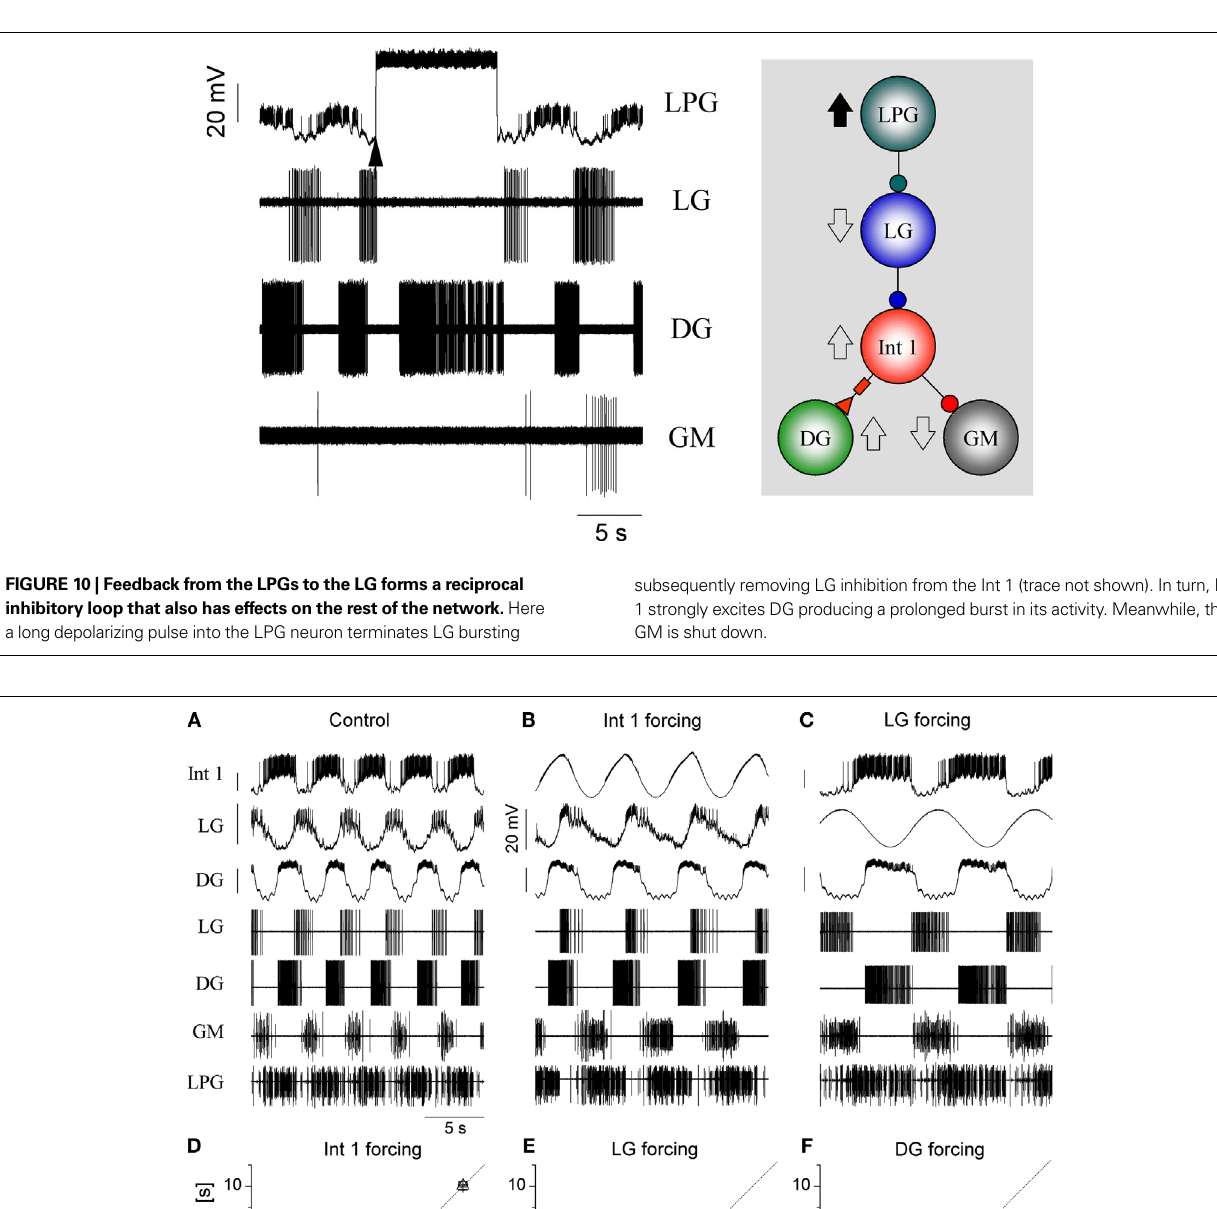
three neurons as a function of the input frequency of the intracellular current that was injected in the Int 1 (D) , LG (E) or DG neuron (F) . Int 1 was the most effective in entraining the entire network (B,D) . Similarly, LG entrained the gastric circuit in a wide range of frequencies (C,E) . At the same time, virtually no synchronization was observed when the DG neuron was stimulated (F) . The gray line in the lower panels marks the burst frequency of the spontaneous